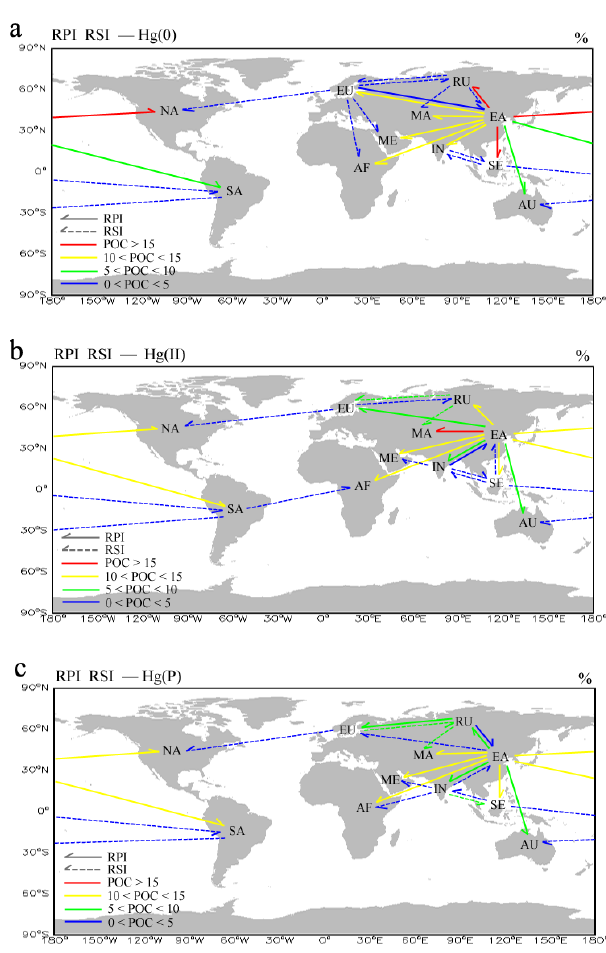
Figure 6. Intercontinental influence patterns based on the RPI (re- gion of primary influence) and RSI (region of secondary influence) for SMC: (a) Hg(0); (b) Hg(II); (c) Hg(P). Arrows point in the di- rection of influence from the RPI or RSI to a receptor region. Colors indicate the magnitude of POC contributed from the RPI or RSI to a receptor